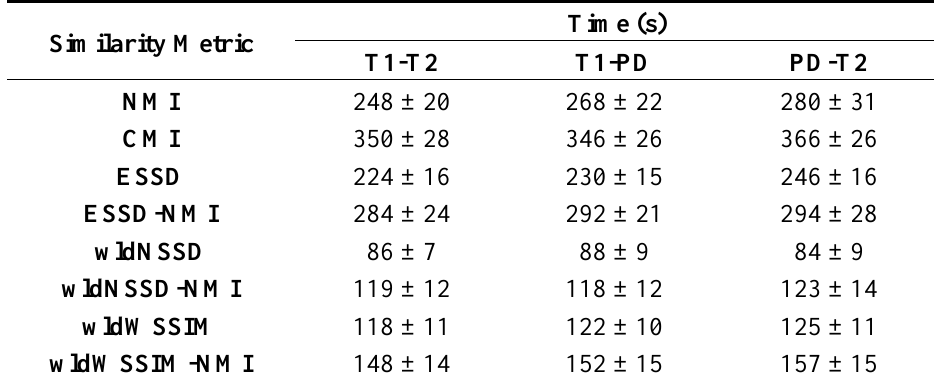
Table 3. Computation time (in seconds) for all the evaluated methods. Similarity